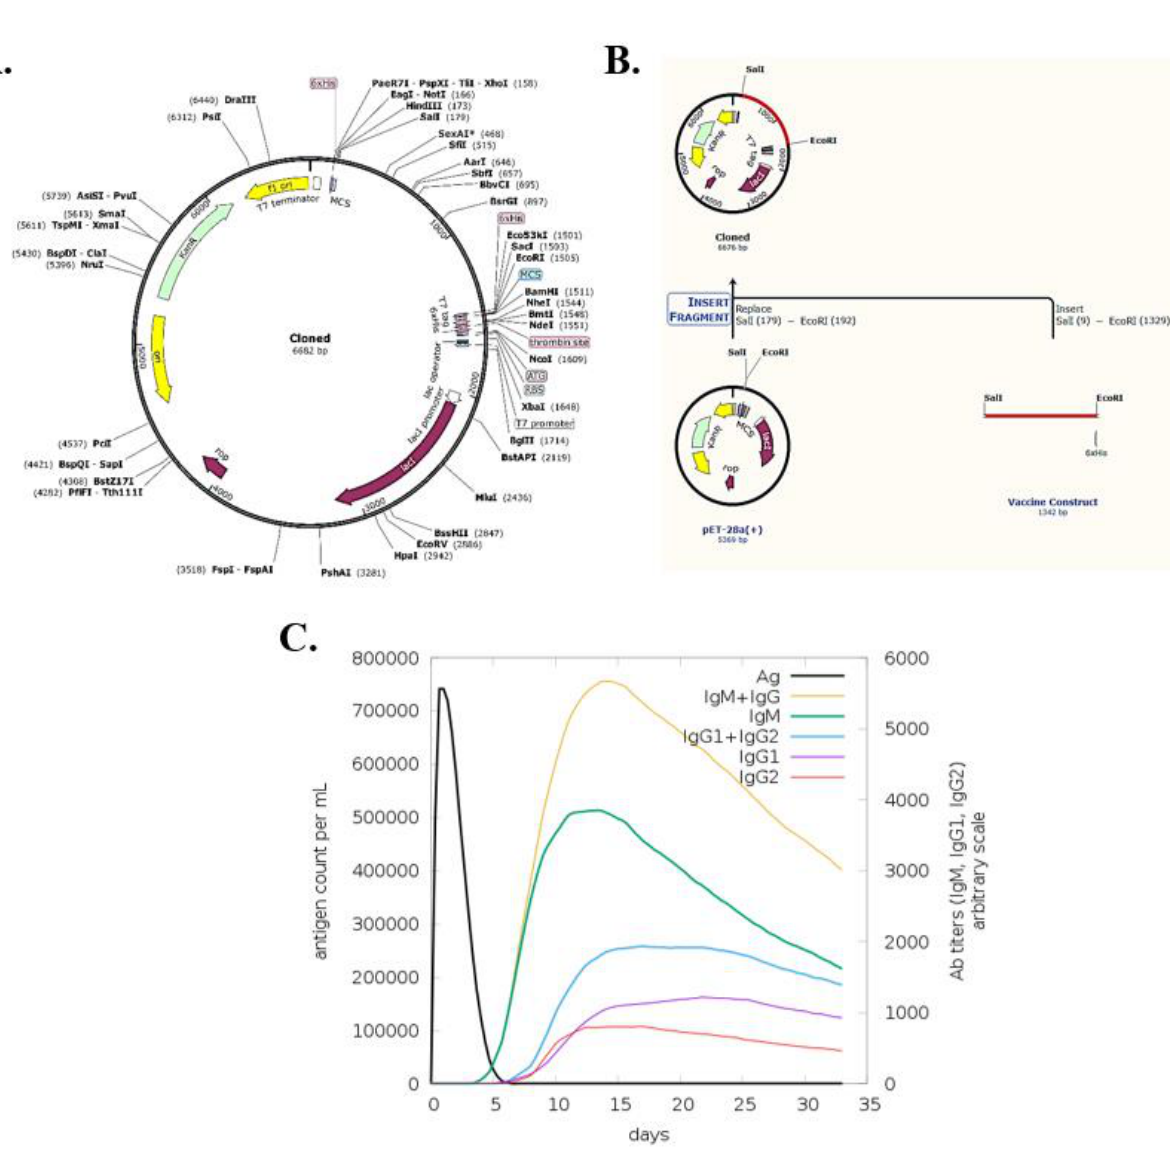
Figure 8. ( A ) The pEt28(a) vector; ( B ) the cloned vector with the red line showing our vaccine inside the plasmid; ( C ) the stimulation and response of IgM and IgG antibodies as compared to the antigen count over the course of the first 35 days.